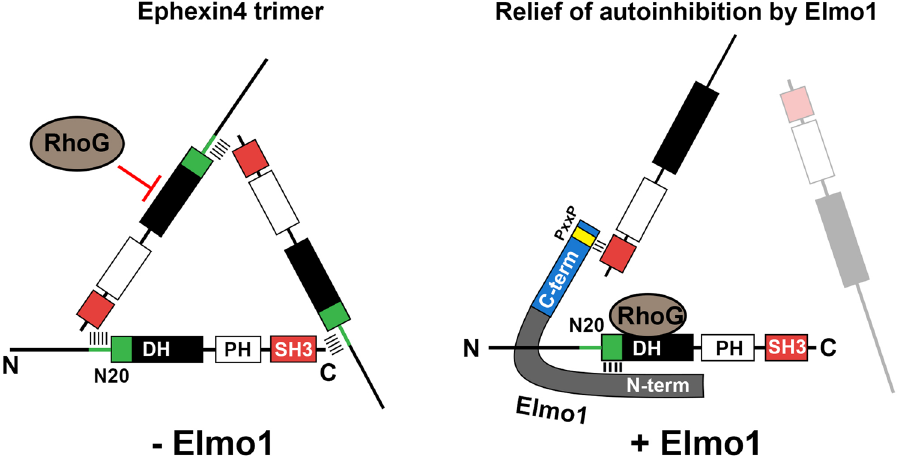
Figure 6. Graphical demonstration for a putative mechanism how Elmo1 relieves the intermolecular steric inhibition of Ephexin4. Intermolecular association of Ephexin4 mediated by interaction of the SH3 domain with the N20 region of Ephexin4 forms a trimeric complex, whose conformation could be a triangle shape. This conformation prevents RhoG access to the DH domain of Ephexin4. Elmo1 interferes the interaction between the SH3 domain and the N20 region of Ephexin4 and then the geometry of Ephexin4 is disrupted, which facilitates RhoG access to the DH domain of